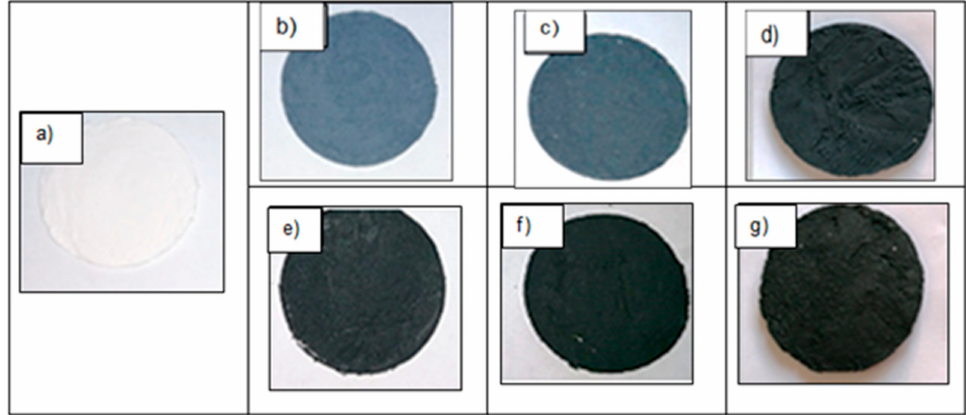
Figure 1. Images of unmodified microcapsules ( a ) and shell-modified MPCM32D microcapsules with different mass fraction: ( b ) poly (3,4-ethylenedioxyoxythiophene) poly (styrene sulphonate) (PEDOT: PSS) 1 wt.%, ( c ) PEDOT: PSS 5 wt.%, ( d ) PEDOT: PSS 10 wt.%, ( e ) multiwall carbon nanotubes (MWCNTs) 1 wt.%, ( f ) MWCNTs 5 wt.%, ( g ) MWCNTs 10 wt.% in a PU